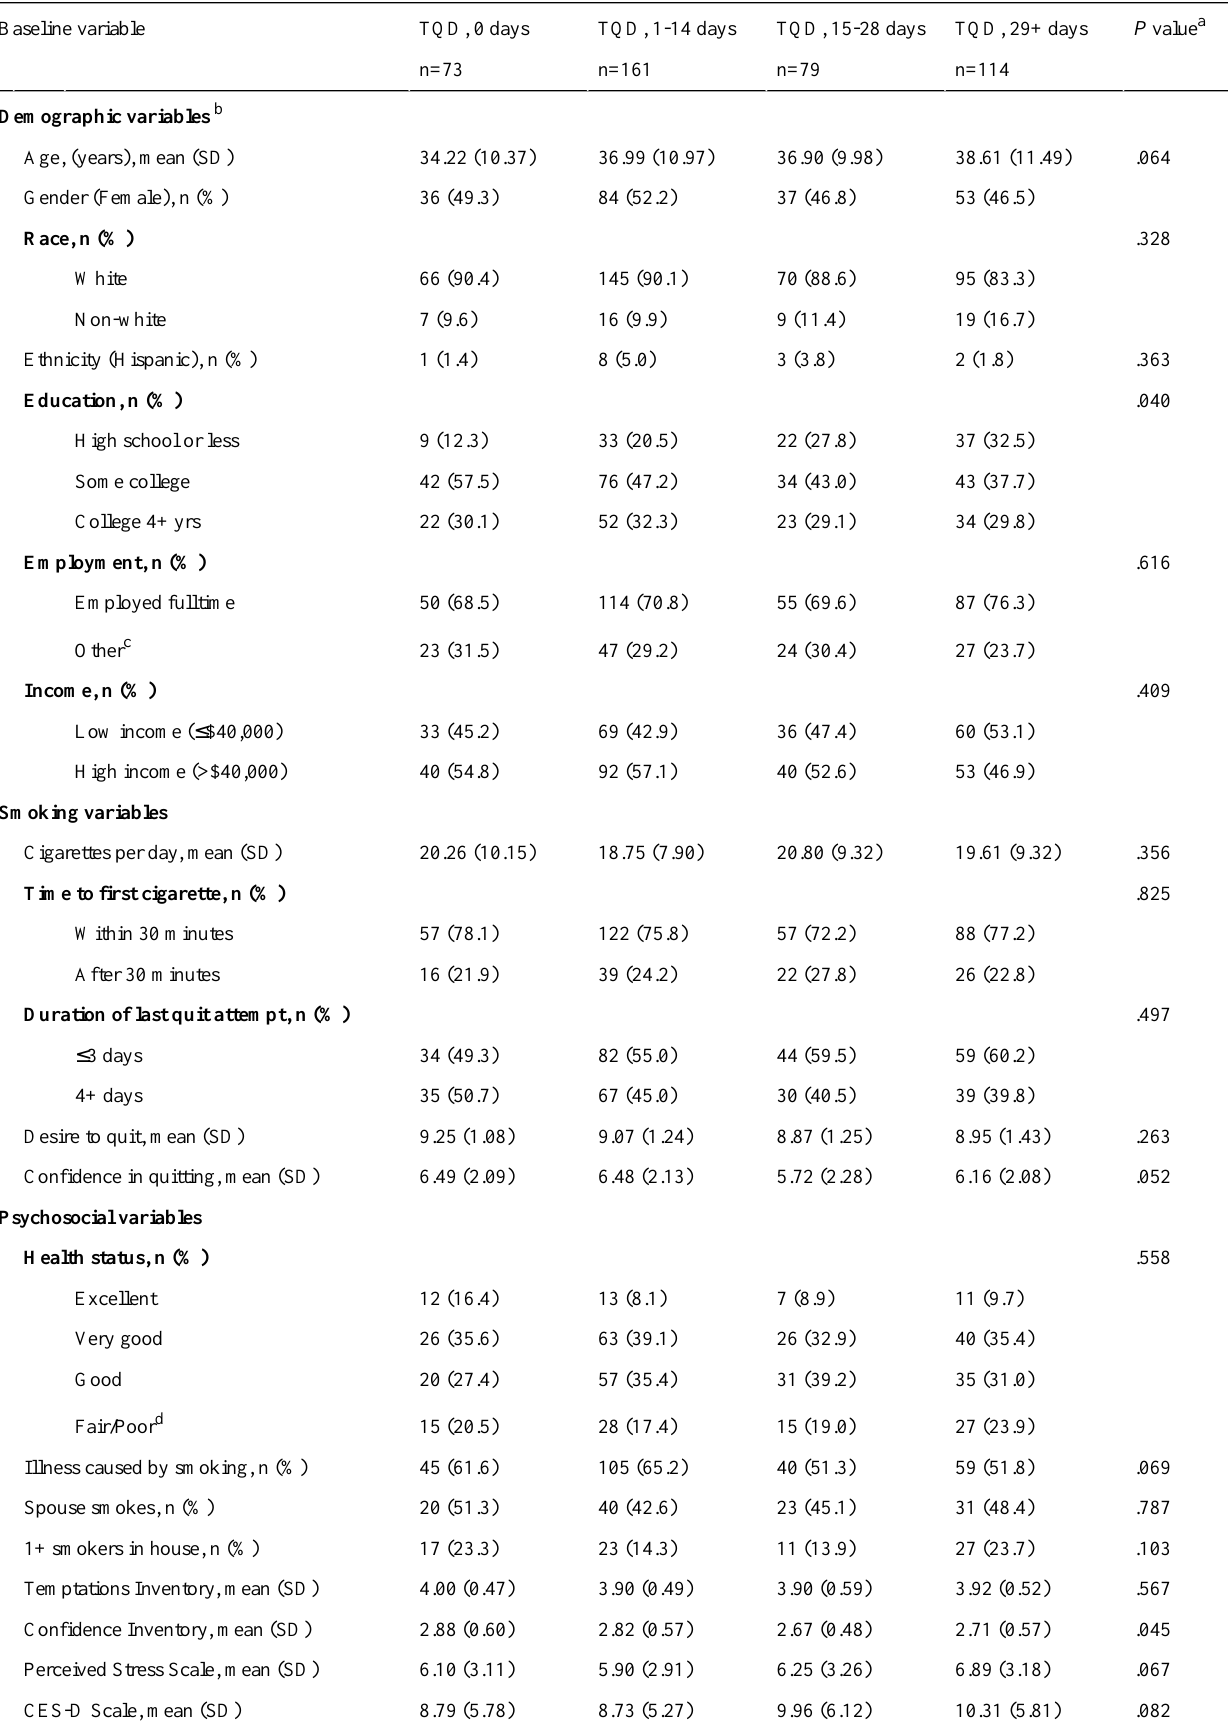
Table 1. Baseline characteristics by latency to target quit date (TQD) relative to website registration